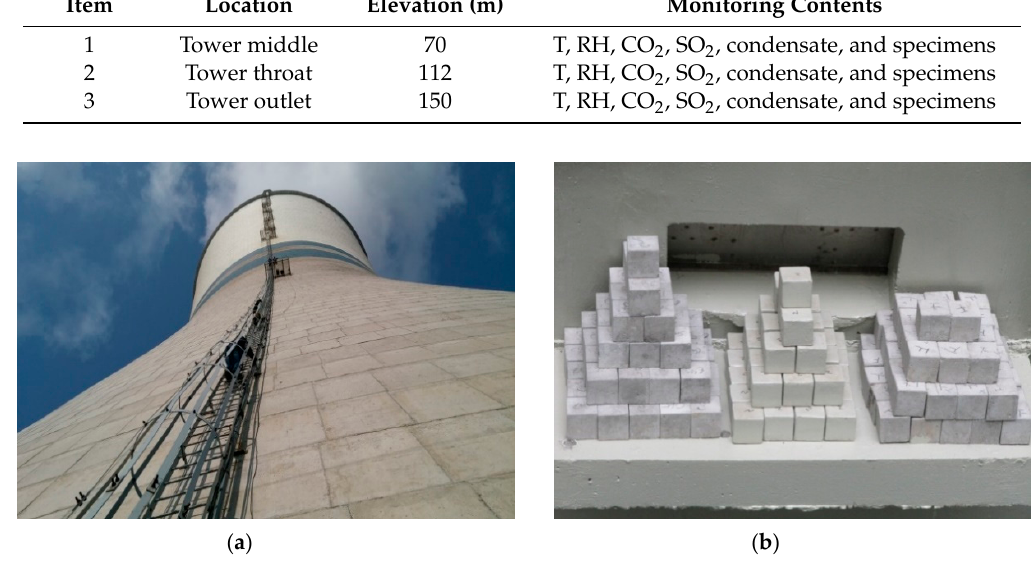
Figure 2. Auxiliary inspection facilities of the cooling tower. ( a ) Steel platform outside the tower; ( b ) concrete platform inside the tower.